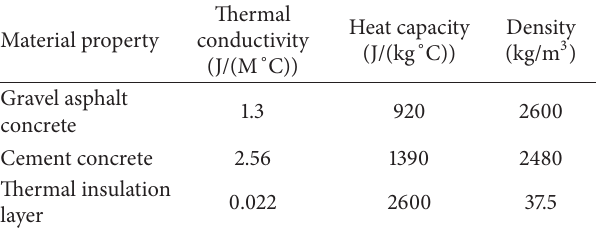
Table 3: Physical parameters of the pavement material.